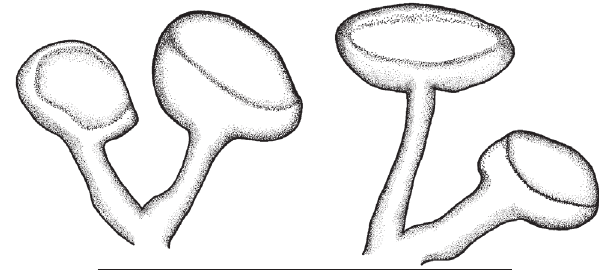
Figure 15. Masteria emboaba sp. nov. paratype (MNRJ 4540), sper- mathecae dorsal view. Scale bar: 100